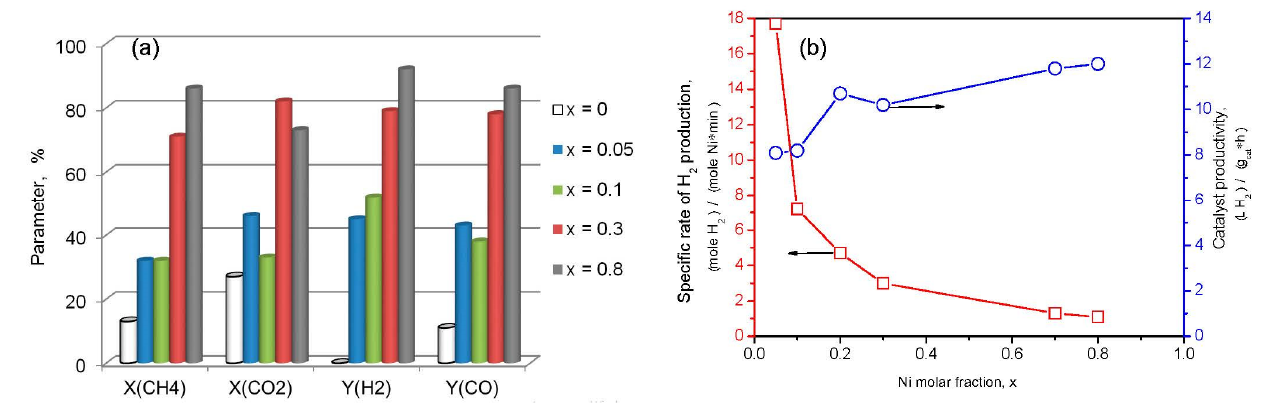
Figure 18. Effect of Ni molar fraction (x) on the parameters during the bi-reforming of methane at 750 °C ( a ), specific rate of H 2 production and catalyst productivity at 850 °C ( b ) over Ce 1 − x Ni x O y samples.